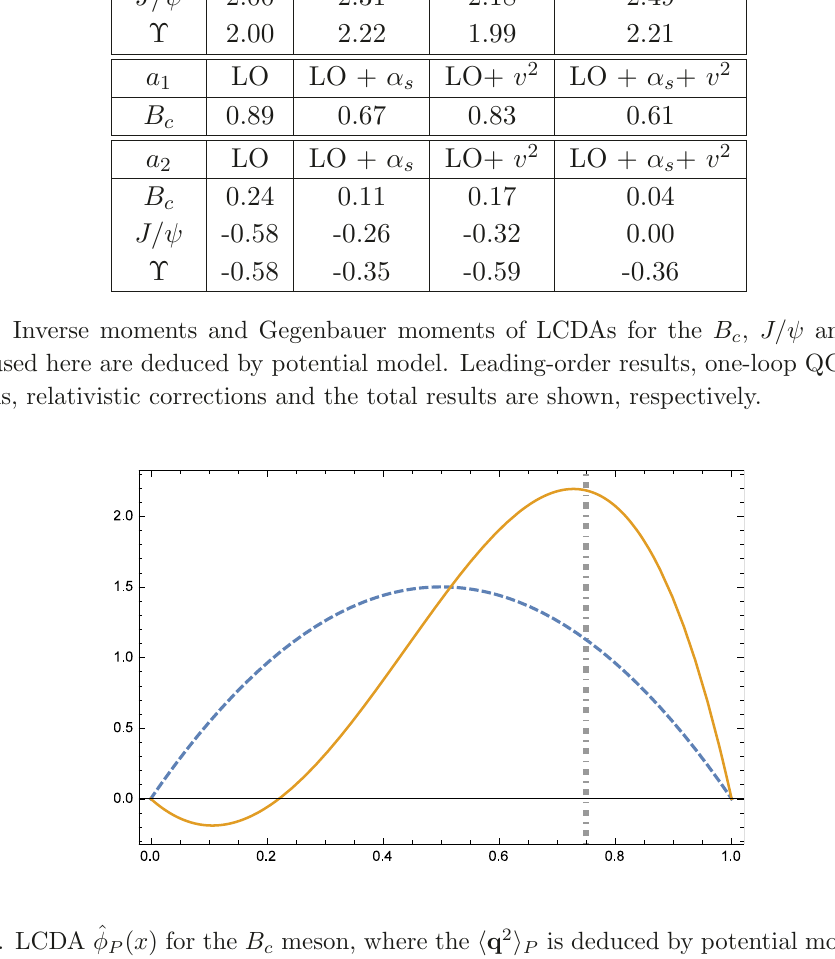
Figure 2 . LCDA ˆ φ P ( x ) for the B c meson, where the in eq. (4.13). The dashed line denotes the asymptotic form φ ( x ) = 6 x (1 line denotes the position x 0 = m b / ( m b + m c ) = 0 . 77. The solid line is obtained by including two Gegenbauer moments derived in eqs. (4.4a) and